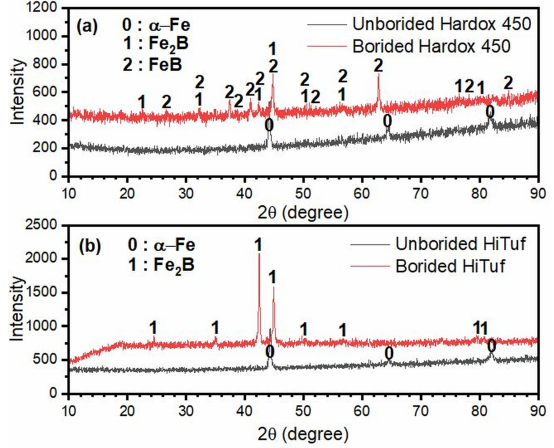
Figure 3: XRD patterns of unborided and borided samples; (a) Har- dox 450, and (b) HiTuf